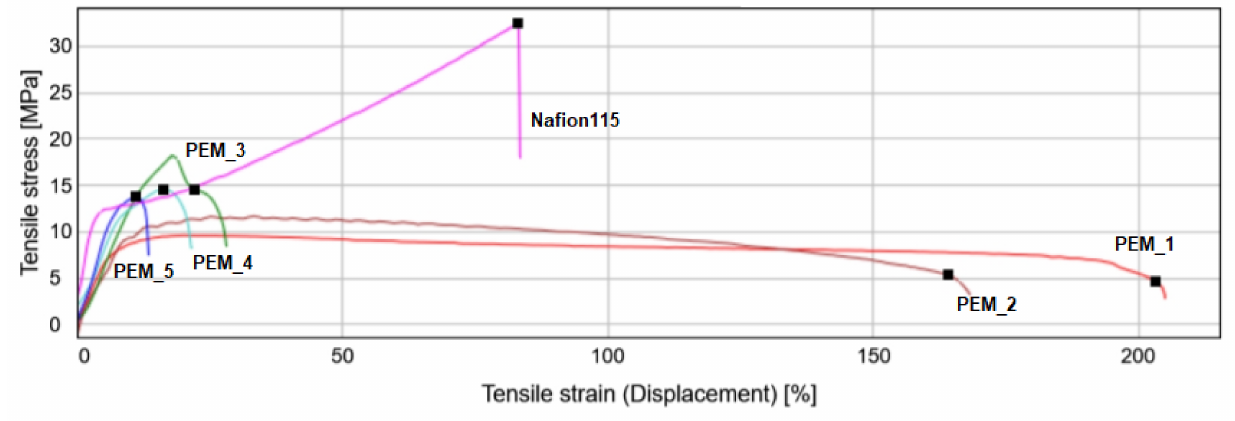
Figure 6. Stress–strain curves were obtained from the tensile test for the PI-PEG SBC membranes with changing dianhydride composition and constant PEG content of 42.1 wt% and Nafion 115, where Nafion 115 is used for comparison